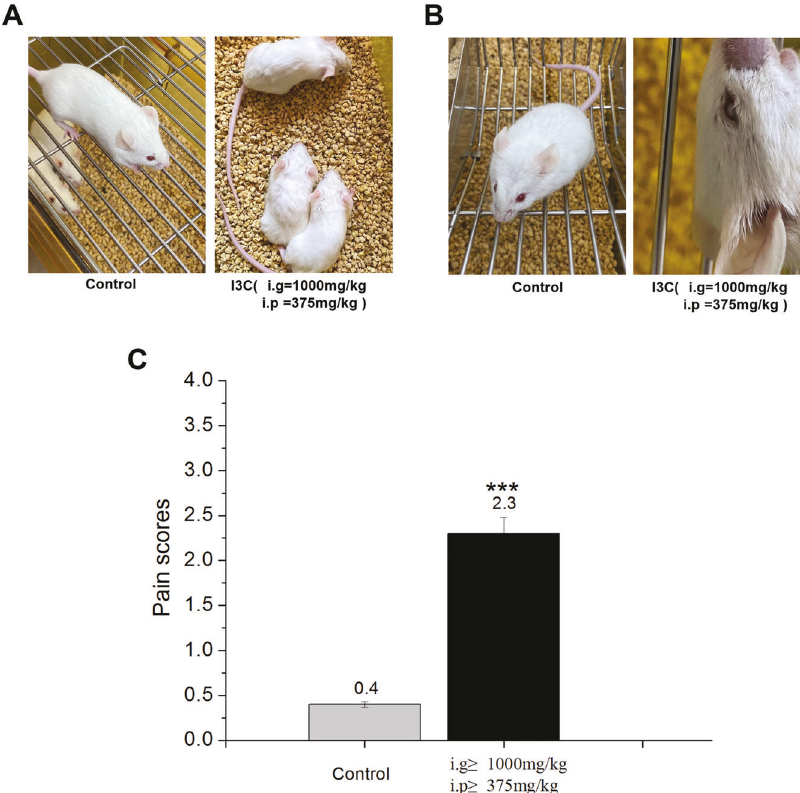
Fig. 5 Abnormal toxic symptoms after I3C administration. A Piloerection and dorsal hair dull phenomenon (contraction of arrector pili muscle) after I3C administration ( n = 6) (i.g. ≥ 1000 mg/kg and i.p. ≥ 375 mg/kg) compared to control mice ( n = 6). B Conjunctival opaci fi cation, iritis, and conjunctivitis with reduced spontaneous activity after I3C administration ( n = 6) (i.g. ≥ 1000 mg/kg and i.p. ≥ 375 mg/ kg) compared to control mice ( n = 6). C The pain score index of experimental animals increased signi fi cantly after I3C administration (Scoring standard of pain index for experimental animals: 0: Normal hair and activity of the experimental animals; 1: part of the hair of the experimental animals was erect and temporarily arched back; 2: the fur of the experimental animals was obviously rough and intermittent arched back; 3: the fur was obviously rough, accompanied by other symptoms such as arched back, slow reaction and behaviour, and even death). Data are expressed as mean ±